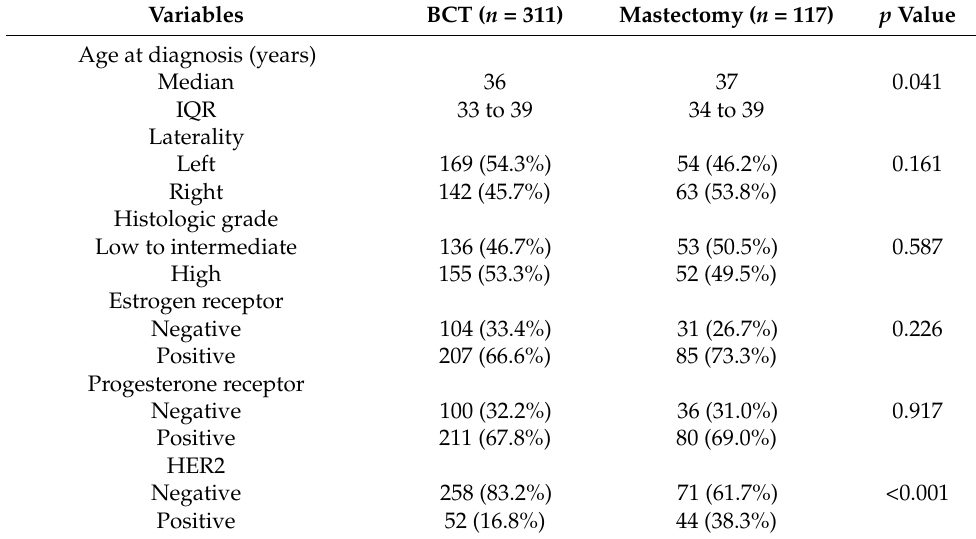
Table 1. Patient